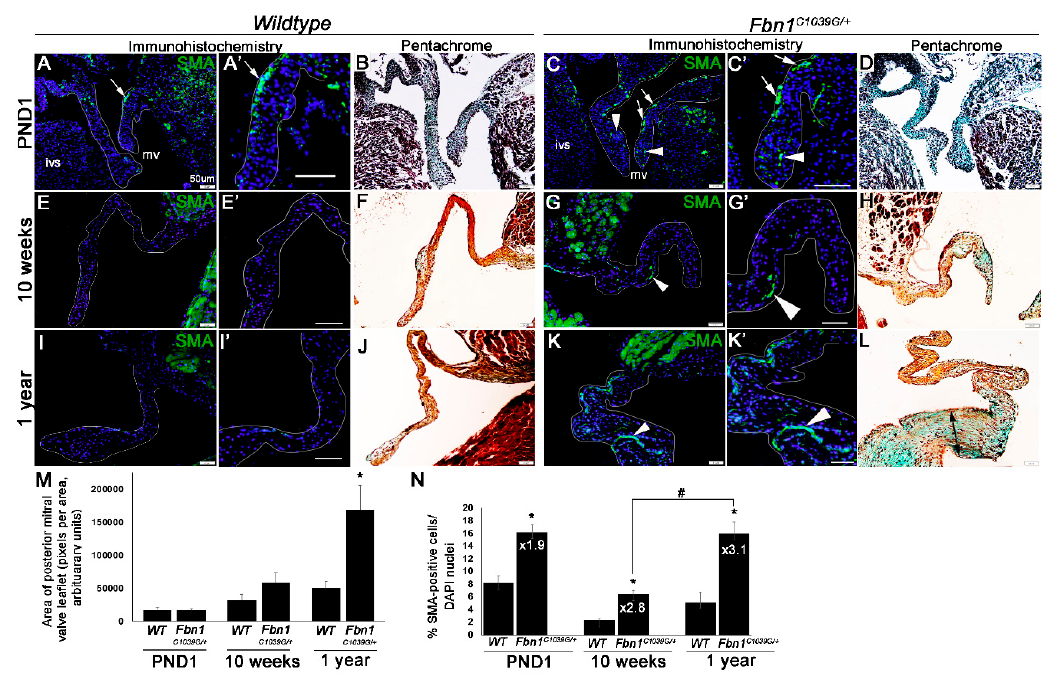
Figure 1. α -smooth muscle actin (SMA) expression increases over time in myxomatous valves from Fbn1 C1039G /+ mice. ( A , C , E , G , I , K ) Representative images of SMA (green) immunofluorescent staining in the interstitium of mitral valves from wild type (WT) ( A , E , I ) or Fbn1 C1039G /+ pups ( C , G , K ) at postnatal day 1 (PND1) ( A – D ); 10 weeks ( E – H ) and 1 year ( I – L ) of age, respectively. Higher magnification insets are shown in ( A’ , C’ , E’ , G’ , I’ , K’ ). White arrows ( A , C ) indicate a developmental population of SMA-positive valve interstitial cells (VICs) in the proximal hinge region of WT ( A ) and Fbn1 C1039G /+ mice ( C ) at PND1. White arrowheads ( C , G , K ) indicate ectopic SMA immunoreactivity in Fbn1 C1039G /+ mice; ( B , D , F , H , J , L ) Pentachrome staining of mitral valve tissue sections of WT ( B , F , J ) and Fbn1 C1039G /+ mice ( D , H , L ); ( M ) Average area of posterior mitral valve leaflet taken from 2D tissue sections at PND1, 10 weeks, and 1 year from WT and Fbn1 C1039G /+ mice, n = 3, * p > 0.05, using one-way ANOVA comparing Fbn1 C1039G /+ mice to WT controls at each time point; ( N ) percentage and fold change of SMA-positive cells (over DAPI-positive nuclei) in Fbn1 C1039G /+ mice compared to WT, at each time point, n = 3, * p > 0.05, using one-way ANOVA comparing Fbn1 C1039G /+ mice to WT controls at each time point. # for Figure 1N indicates statistical significance, p > 0.05 as indicated.